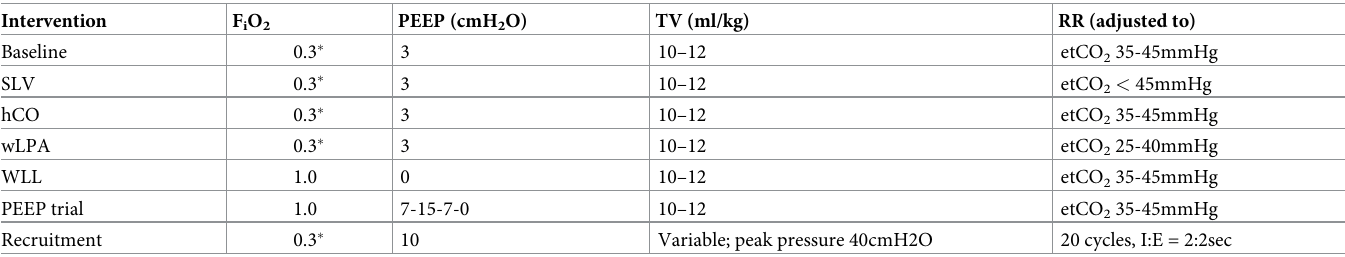
Table 1. Ventilator